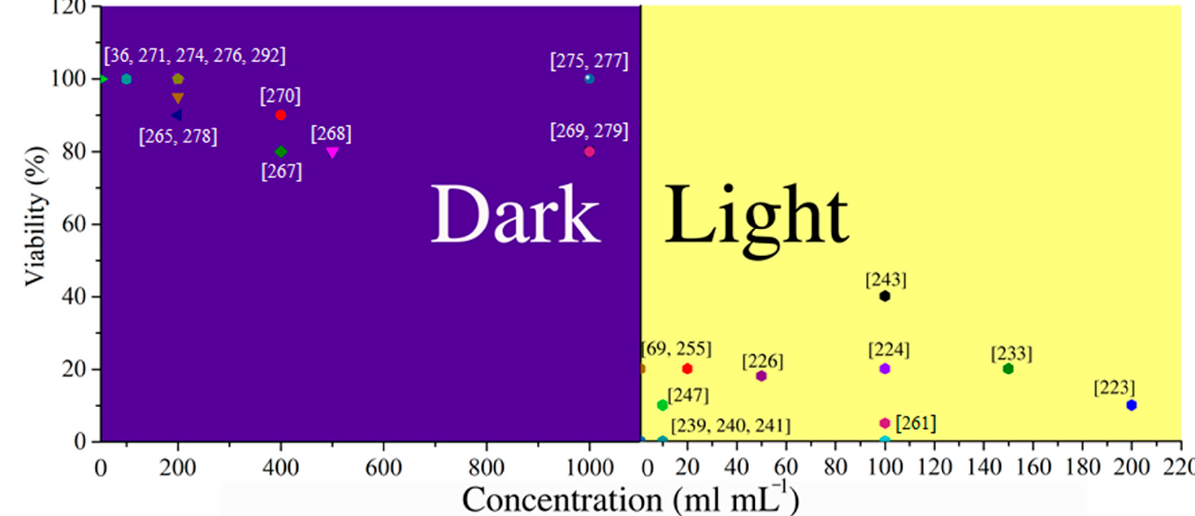
Figure 14. Cytotoxicity of carbon-based nanoparticles in the dark (violet, left panel), and under light exposure (yellow, right panel). Dots in the graph indicate the values of cytotoxicity as a function of studied doses of the C/GQDs, including the appropriate references [37,69,223,224,226,233,239–